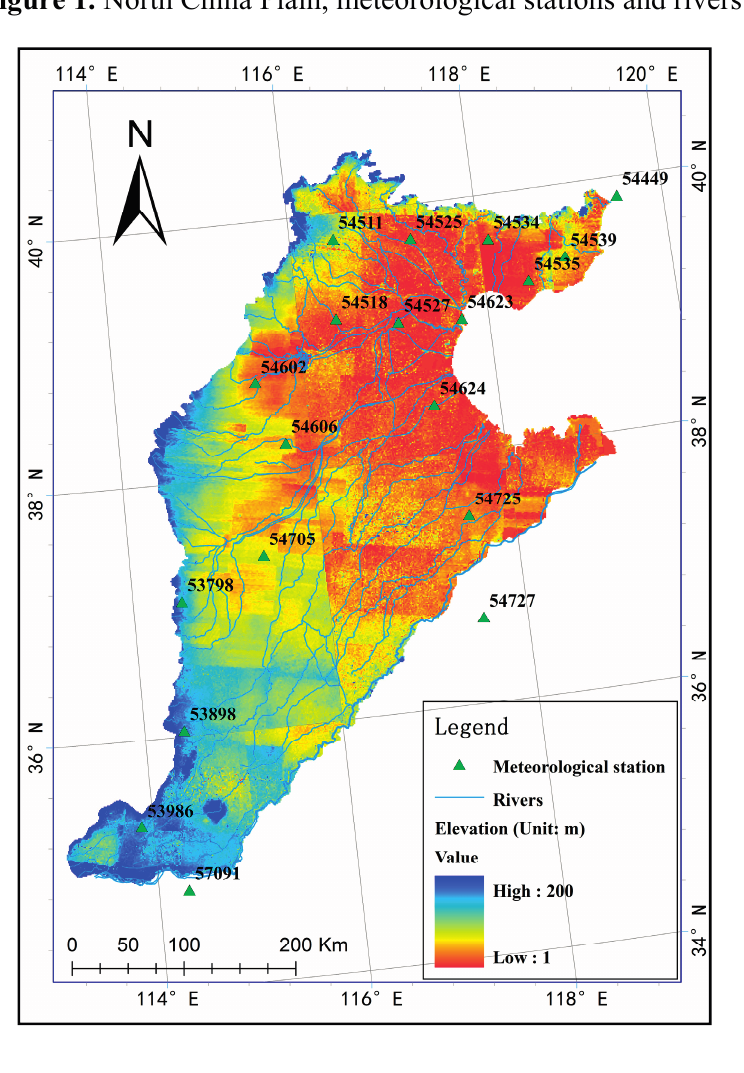
Figure 1. North China Plain, meteorological stations and